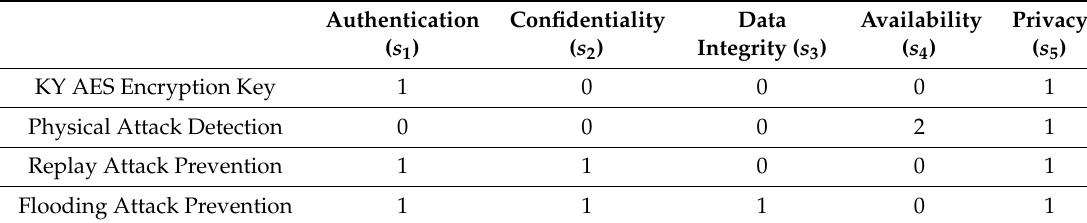
Table 9. Numeric reward matrix.